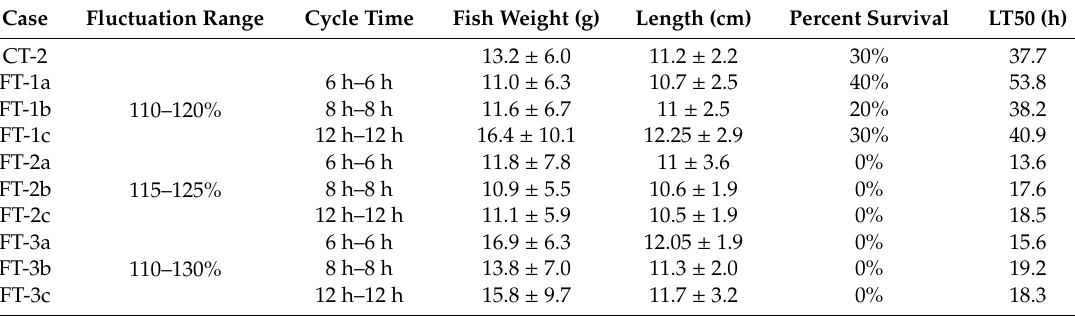
Table 3. The LT50 of experimental fish in each case.